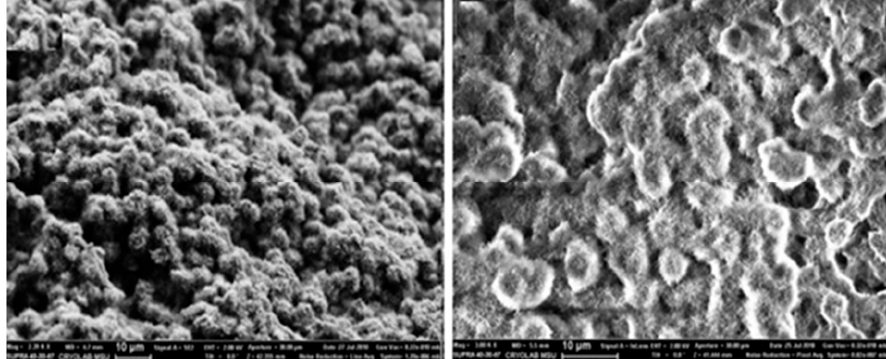
Figure 2. Scanning Electron Microscope images for the chitosan-based aerogel. Adapted from Rubina et al.